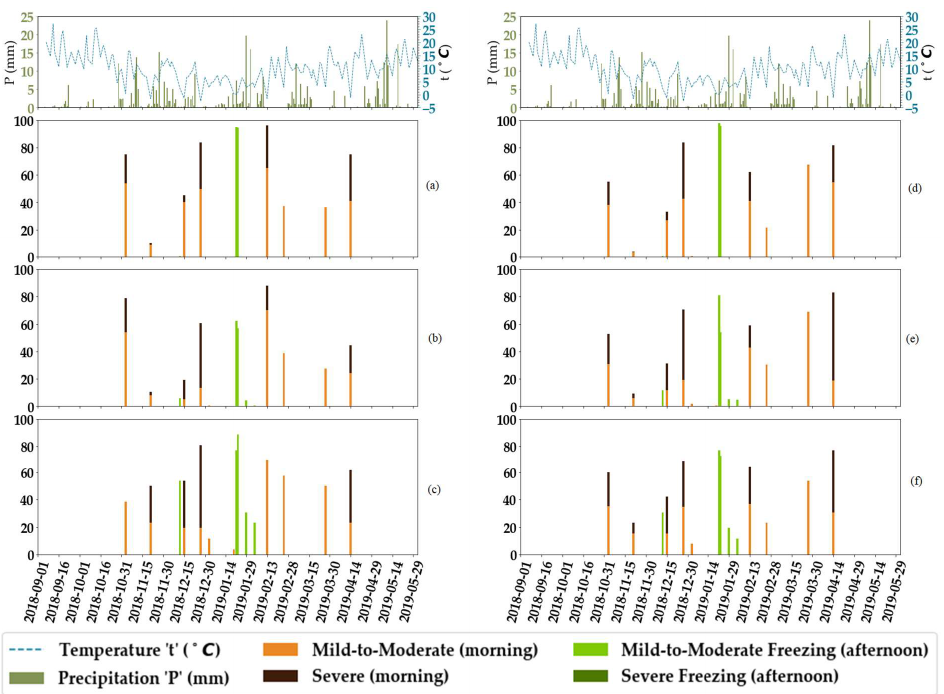
Figure 11. The distribution of mild-to-moderate and severely frozen plots in site A, for each S1 acquisition, and using VH and VV polarizations after applying the temperature filter. ( a ) VH-LC1, ( b ) VH-LC2, ( c ) VH-LC3, ( d ) VV-LC1, ( e ) VV-LC2, ( f ) VV-LC3. Precipitation (P) and temperature (t) are given in the graph at the top.